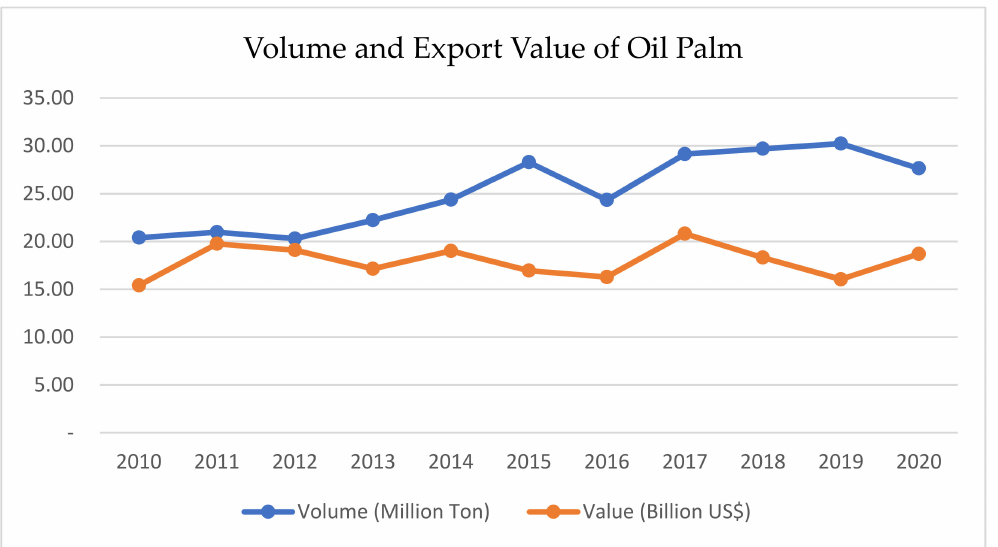
Figure 2. Volume and export value of palm oil in Indonesia from 2010 to 2019, (processed from statistic data) [1,44].